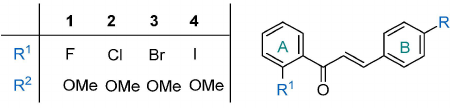
Figure 2. Antidiabetic chalcone derivatives ( 1 – 4 ) developed by our research group.